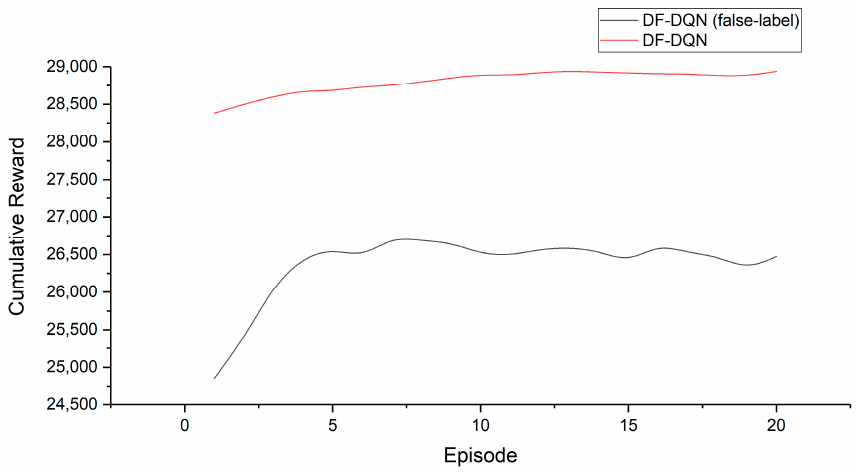
Figure 10. Comparison of cumulative reward between DF-DQN (false label) and DF-DQN. DF-DQN (false label) and DF-DQN both converged at last. Although the wrong label